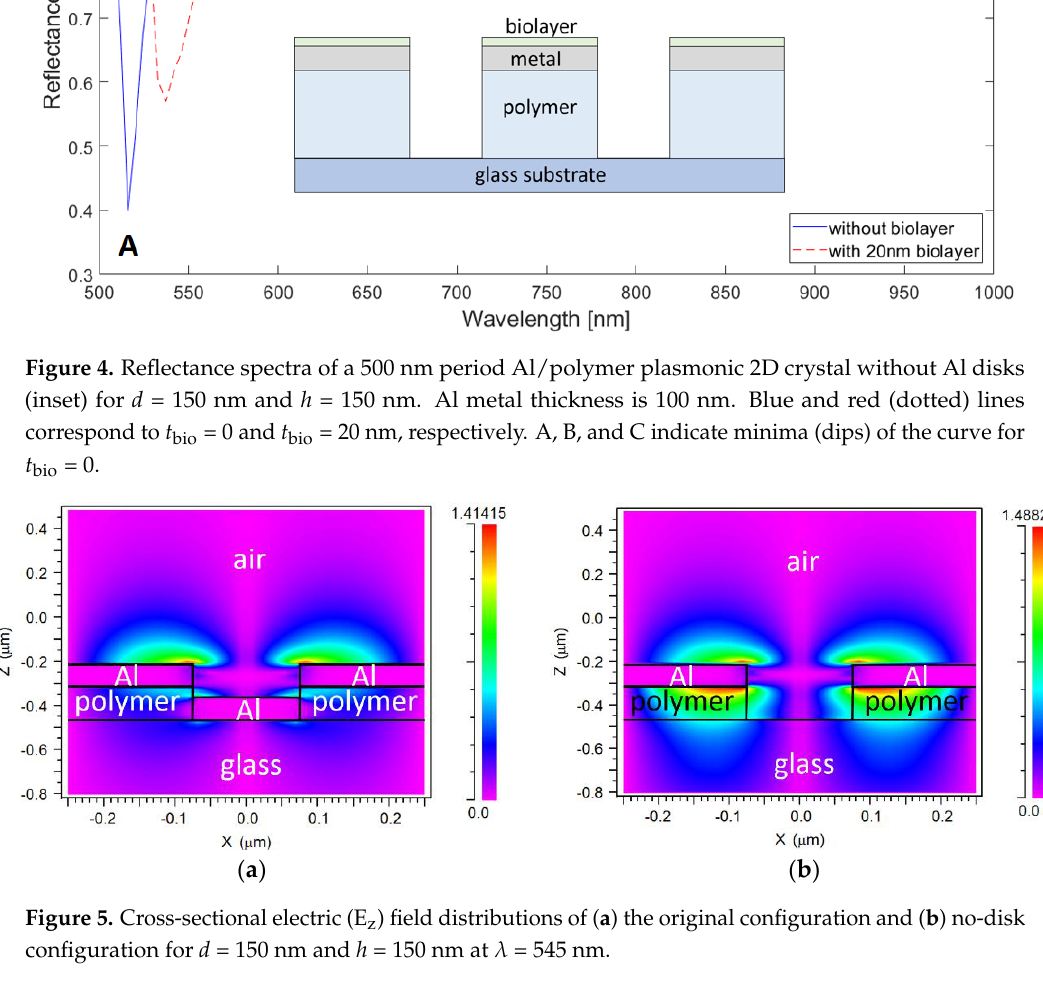
Figure 5. Cross-sectional electric (E z ) field distributions of ( a ) the original configuration and ( b ) no-disk configuration for d = 150 nm and h = 150 nm at λ = 545 nm.